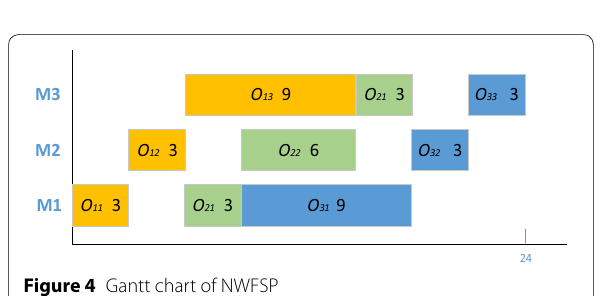
Figure 4 Gantt chart of NWFSP